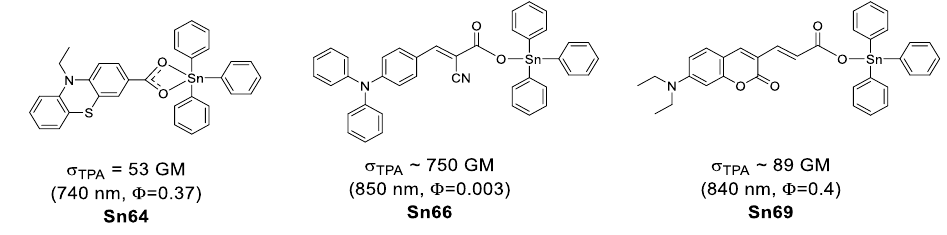
Figure 52. Some organostannoxanes with TPA properties.